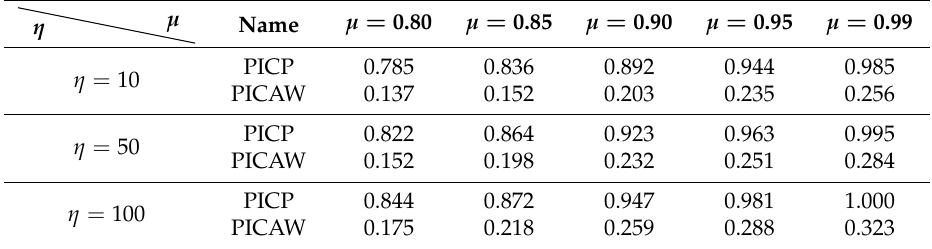
Table 1. Comparative results with different η and µ of CWC. CWC: coverage width-based criterion; PICP: prediction interval coverage probability; PICAW: prediction intervals covered-normalized average